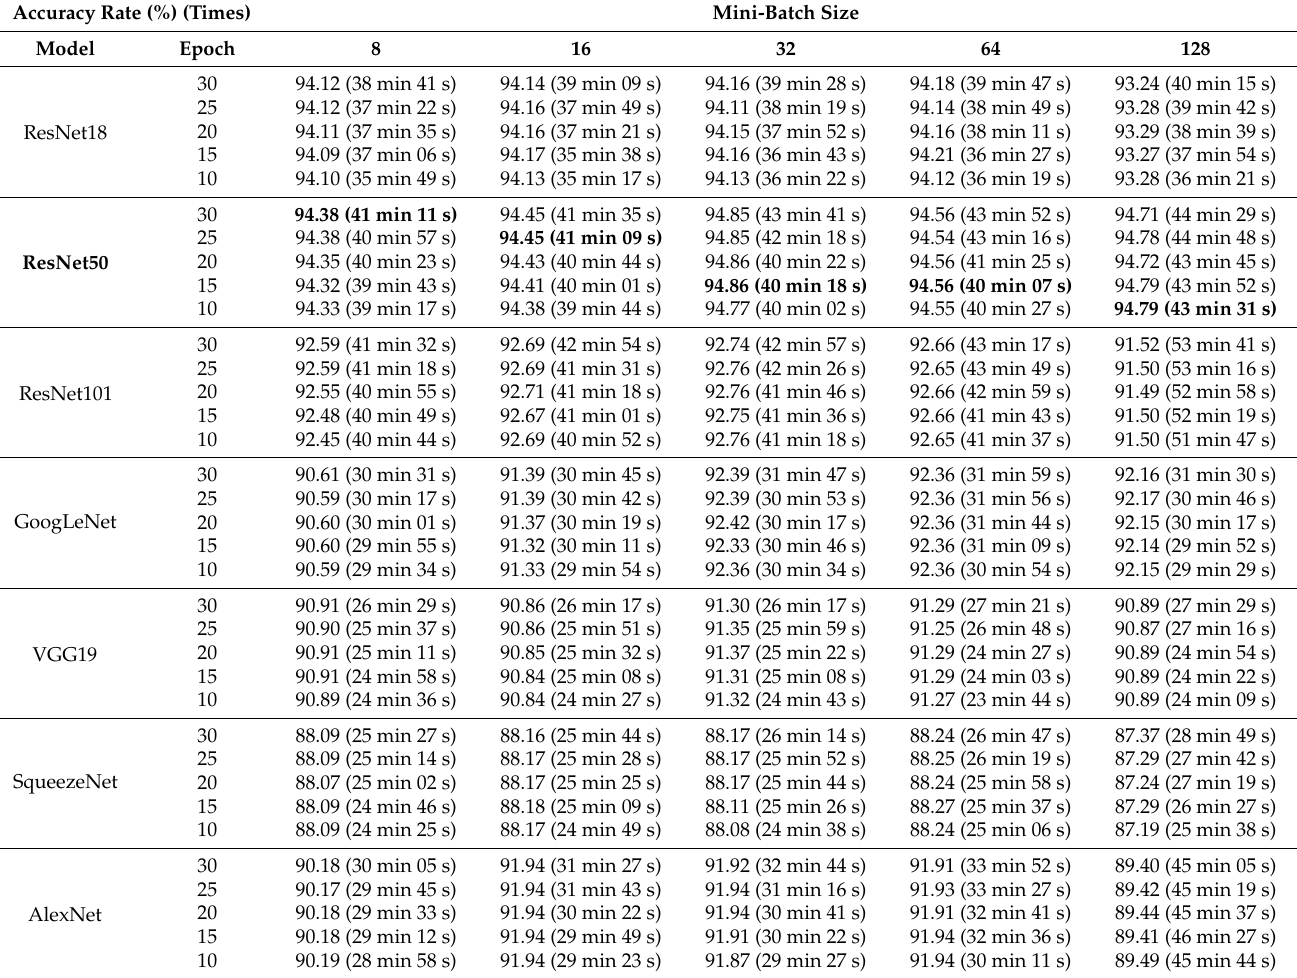
Table 9. Experiment II: the best result of eight tissue classes (Kather-texture-2016-image). Accuracy Rate (%) (Times)